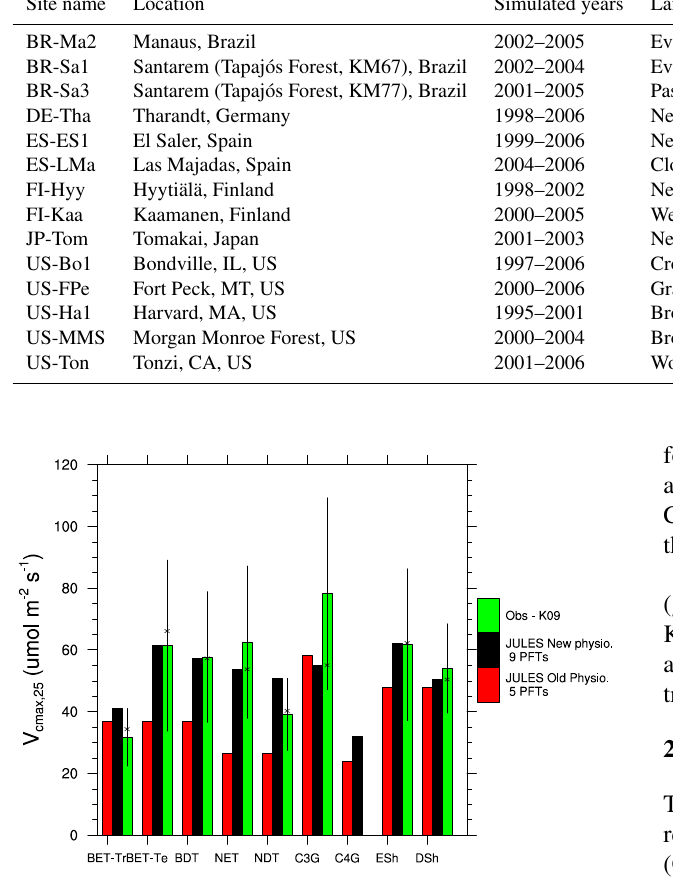
Figure 2. V cmax,25 for the new nine PFTs (black), from the compa- rable PFT from the TRY data (Kattge et al., 2009) (green), and from the standard five PFTs (red). Asterisks indicate the V cmax,25 for JULES9 prior to calibration based on the FLUXNET sites. The stan- dard deviation reported in Kattge et al. (2009) are also shown for the observations with the vertical lines. BET-Tr – Tropical broadleaf ev- ergreen trees, BET-Te – Temperate broadleaf evergreen trees,